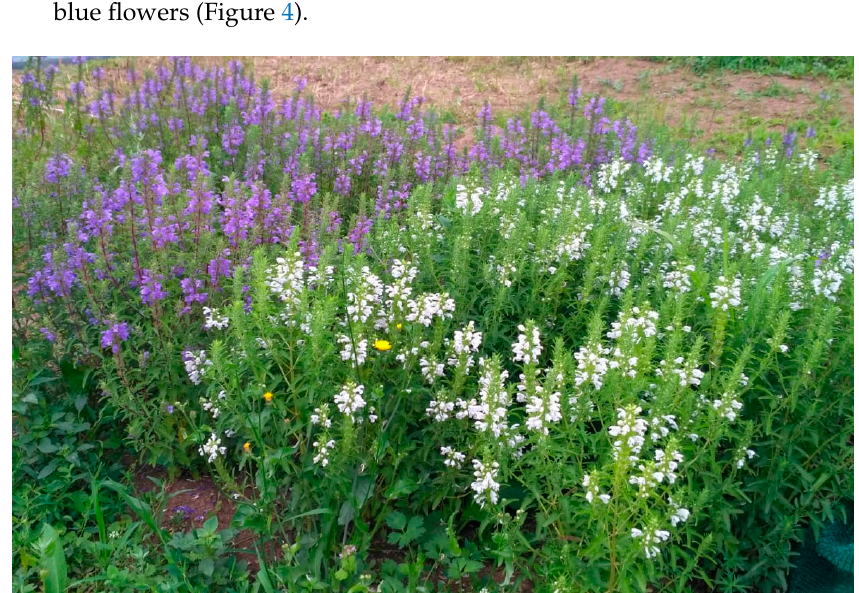
Figure 4. The aspect of D. moldavica cultivars before harvesting.